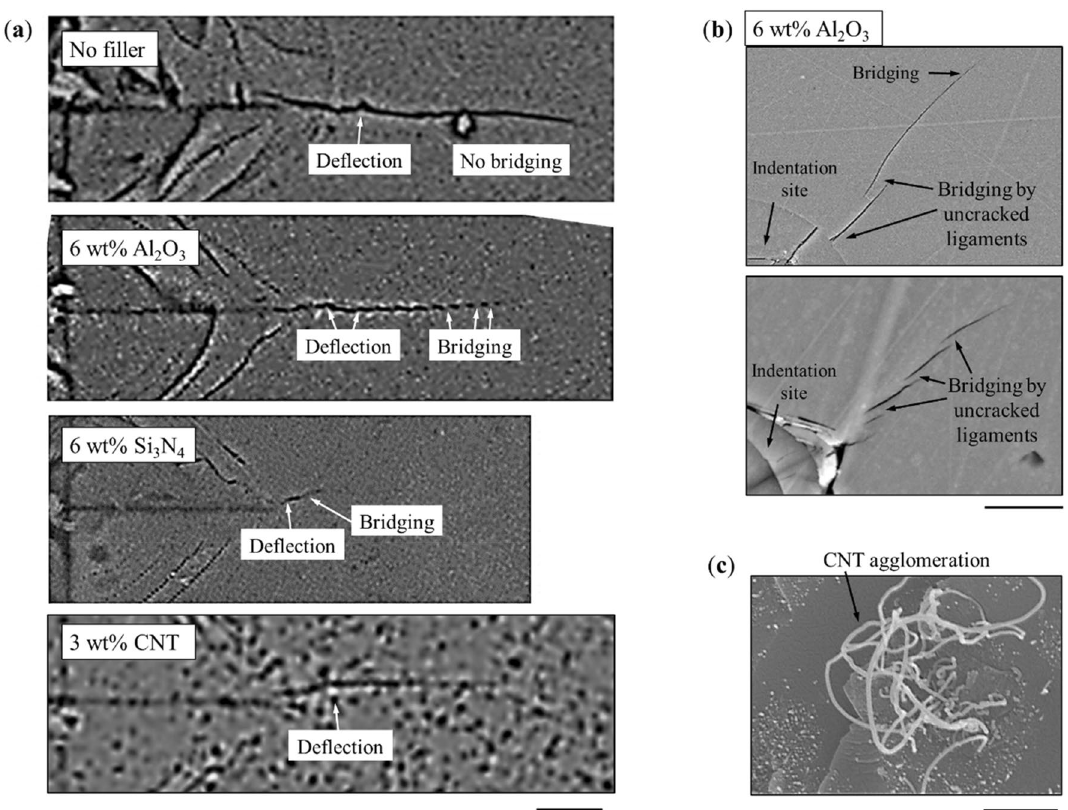
Figure 3. Toughening mechanisms shown on representative SEM micrographs of micro-indentation cracks. ( a ) Comparison between crack propagation in s amples are with no fillers, 6 wt% Al 2 O 3 , 6 wt% Si 3 N 4 , and 3 wt% CNT. ( b ) A closer look at the crack bridging toughening mechanism in the Al 2 O 3 modified PDCs. ( f ) Nanotube agglomeration observed on the surface of CNT-modified samples. All the cracks were obtained with the same force on PDCs. For the representative images of all the samples, see Fig. S1. Scale bars ( a ) 15 µm; ( b ) 15 µm, and ( c ) 1